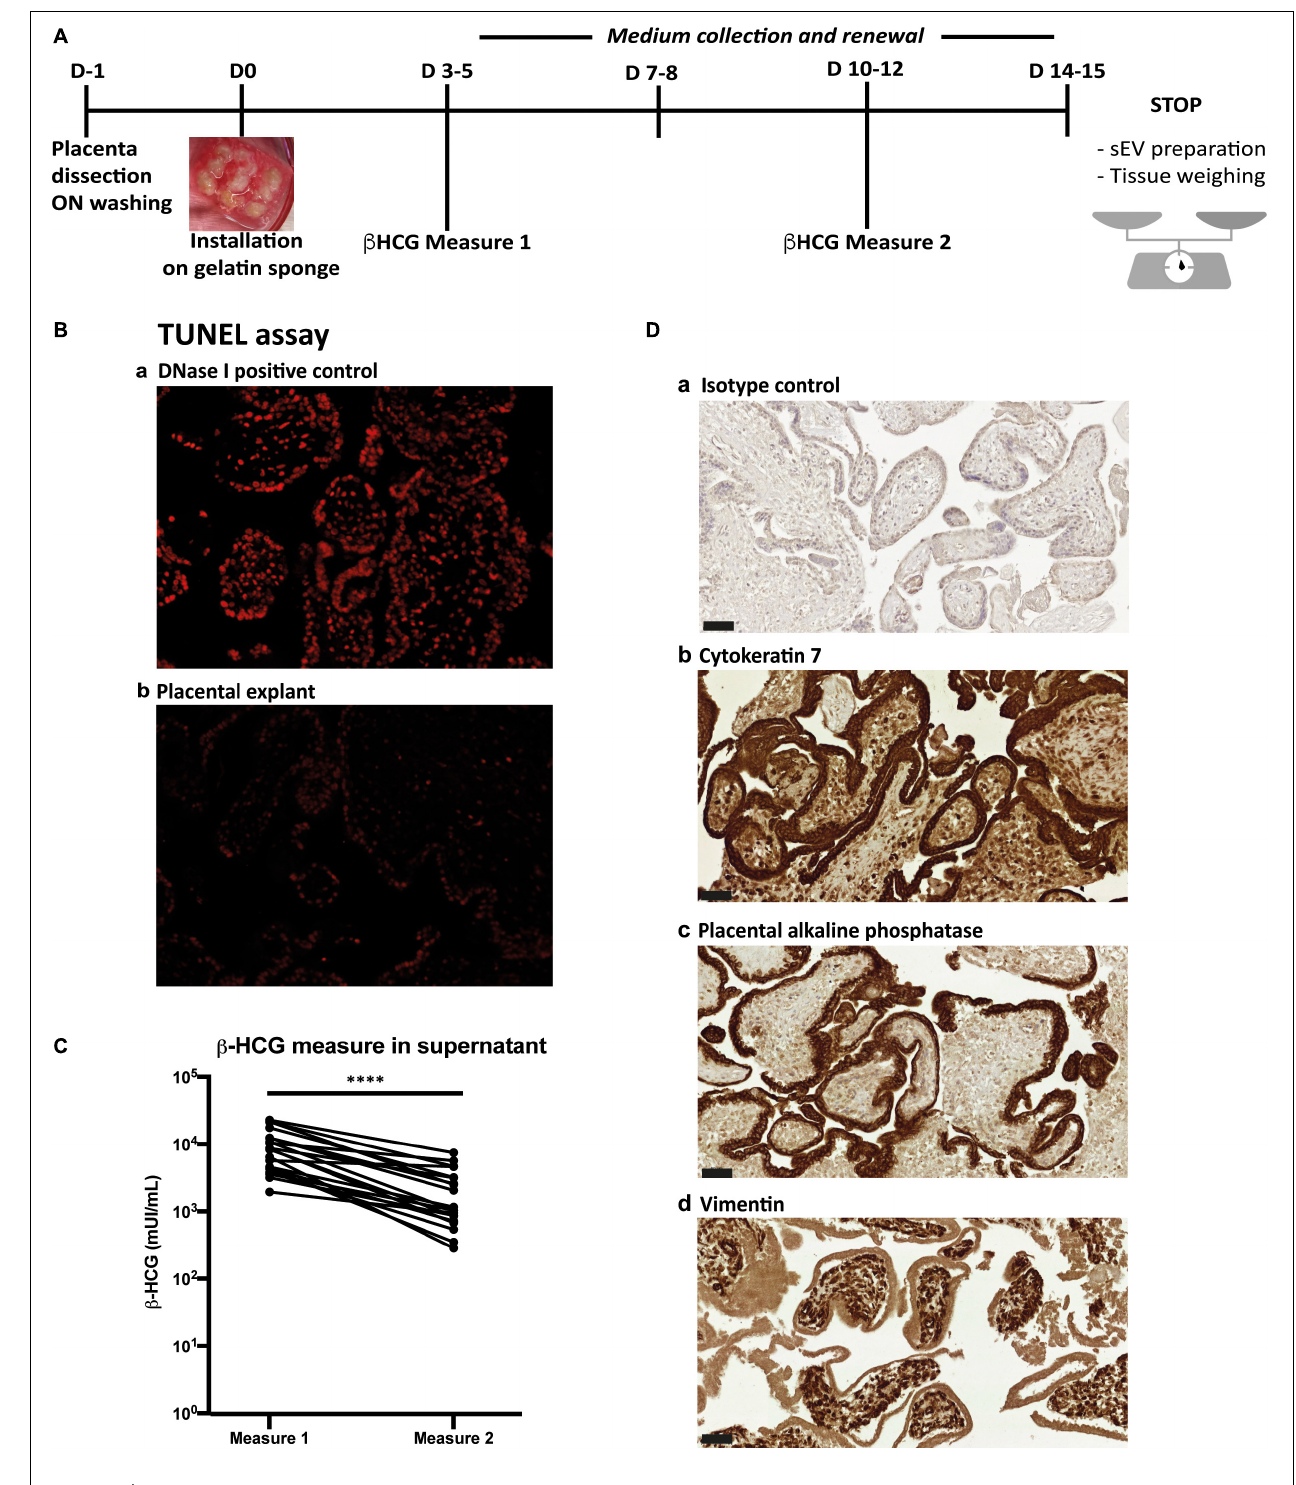
FIGURE 1 | Placental histoculture set-up and characterization. (A) Pipeline of placental histoculture model. (B) Fluorescence-based TUNEL assay done on cross section of placental villi from histoculture at day 14. a- DNase I positive control; b-TUNEL assay. Image representative from three independent experiments. (C) β -HCG measurements in histoculture supernatants. For each placental histoculture, β -HCG measurement was realized in the supernatant between days 3–5 (measure 1) and days 10–12 (measure 2). ∗∗∗∗ p < 0.0001 by paired t -test ( n = 21 independent histocultures). (D) Cross sections of immunohistochemistry and hematoxylin staining of placental villi from histoculture at day 14, observed by bright field microscope. a- Isotype control; b- Cytokeratin 7; c- PLAP; d- Vimentin. Image representative from at least three independent experiments. Scale bar = 50 µ m.